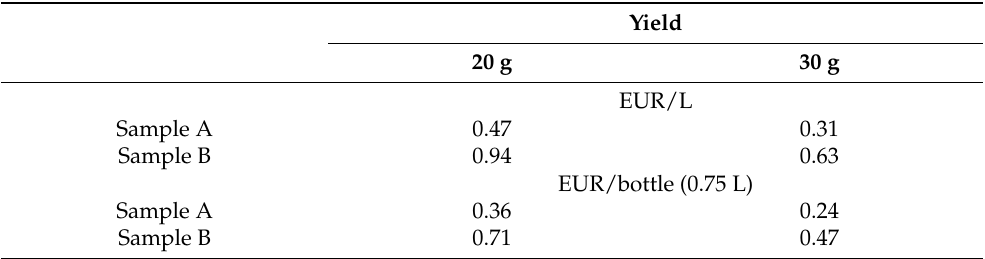
Table 5. Total cost of the production and use of UGE per sample and the different dry extract yield per liter of liquid